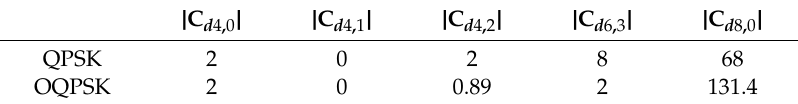
Table 3. Theoretical values of HOC after di ff erence between QPSK and OQPSK.